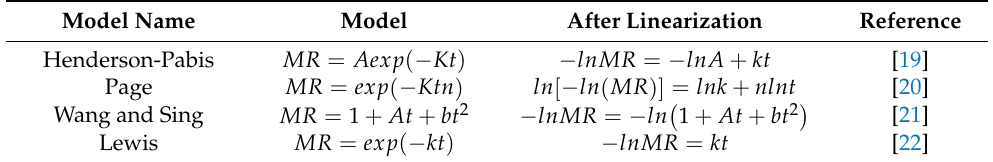
Table 3. Mathematical models for the data processing of kelp drying tests.